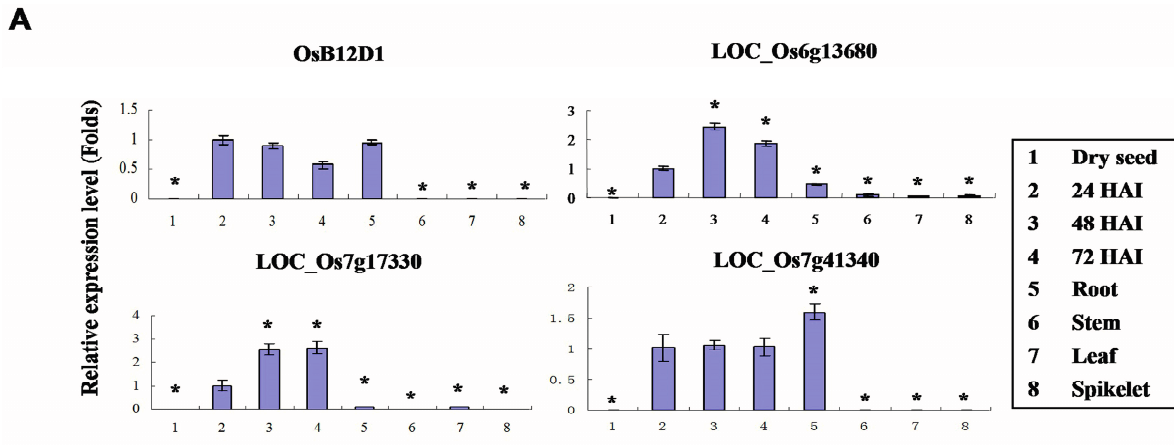
Figure 2. Expression analyses of OsB12Ds . ( A ) qRT-PCR analysis of the OsB12Ds expressional pattern in different stages of rice seed germination and various tissues. The RNA was extracted from embryos of the dehulled rice seeds at 0, 24, 48, and 72 h after imbibition (HAI) under normal condition and tissues of root, stem, leaf and spikelet of 60 day-old rice plant; ( B ) Digital expression patterns of OsB12Ds. Five OsB12Ds were obtained from the ricearray database using meta-analysis tool [25]; ( C ) Rice seeds germinating under multiple treatments for 24 h. From left to right: CK, control; GA, 200 µM GA3; ABA, 50 mM ABA; NaCl, 200 mM NaCl; Mannitol, 20% Mannitol; Low Tem, seeds were imbibed at 4 °C for three days in the dark before being transferred to germinate under benign condition; High Tem, seeds pretreated at 40 °C and 100% relative humidity for three days; NaN , 1 mM 3 ; SHAM, 15 mM SHAM; 5 mM H O ; 20 mM H O ; Flooding, seeds were directly NaN 3 2 2 2 2 submerged in 8 cm deep of distilled water; ( D ) qRT-PCR analysis of the OsB12D expression under multiple treatments. The embryos of 24 HAI rice seeds under multiple treatments were excised manually and used for RNA extraction. The expression of OsB12D1 was normalized to the expression of rice 18 S rRNA. The values are the means with the standard deviations ( n = 3), asterisks ( * p < 0.01, Student’s t -test) represent significant differences from the expression level in 24 HAI seed embryo under normal